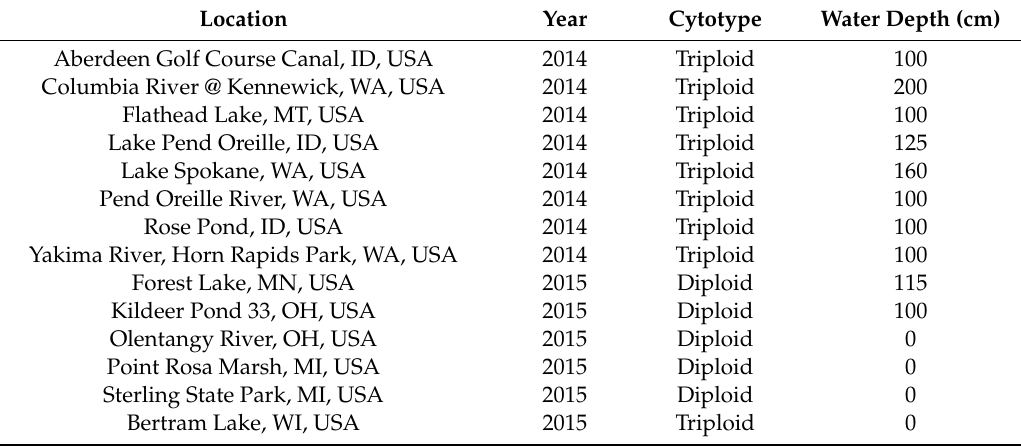
Table A1. Locations where B. umbellatus water depth was measured during surveys from 2014 until